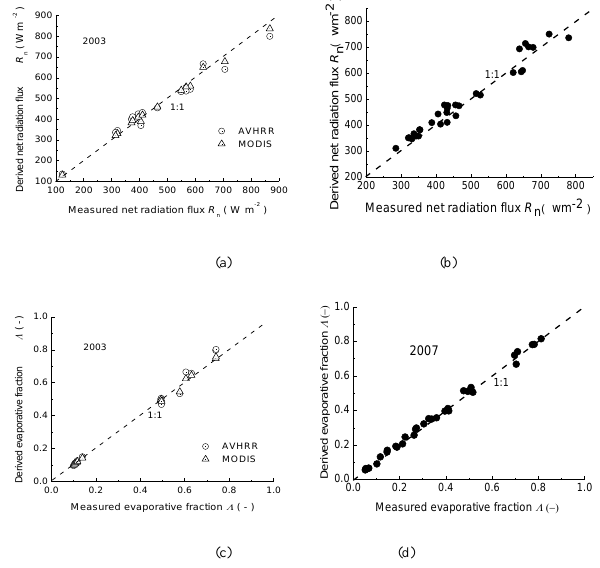
Fig.4 Comparison between the derived net radiation flux ( R n ), evaporative fraction ( Λ ) , and the field measurement values, together with a 1:1 line in 2003 and 2007.